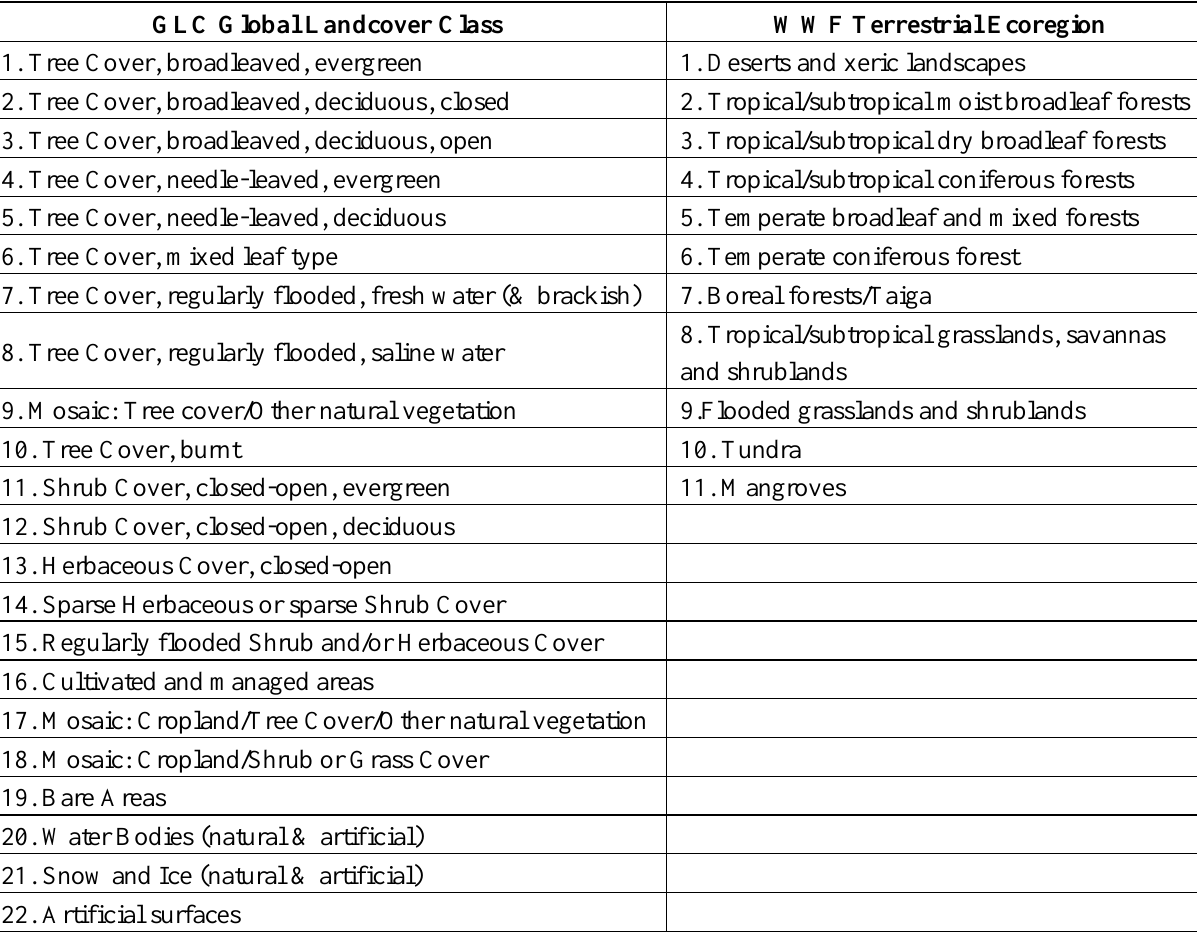
Table 1. Classes of landcover and ecoregion used to define global ecosystem types in this study. GLC Global Landcover